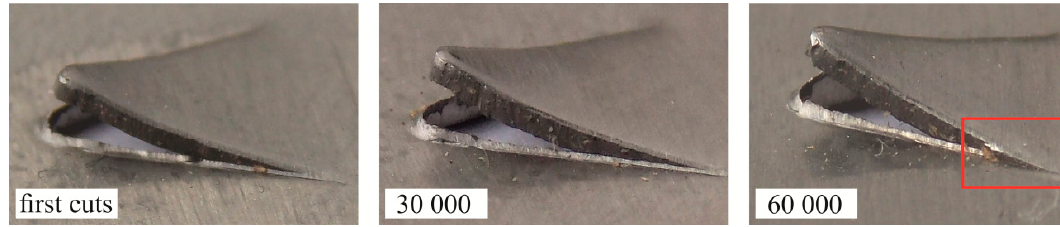
Figure 17. Burr ( b h ) on the edge of the sheet for hook cuts out with a clearance of 15%.